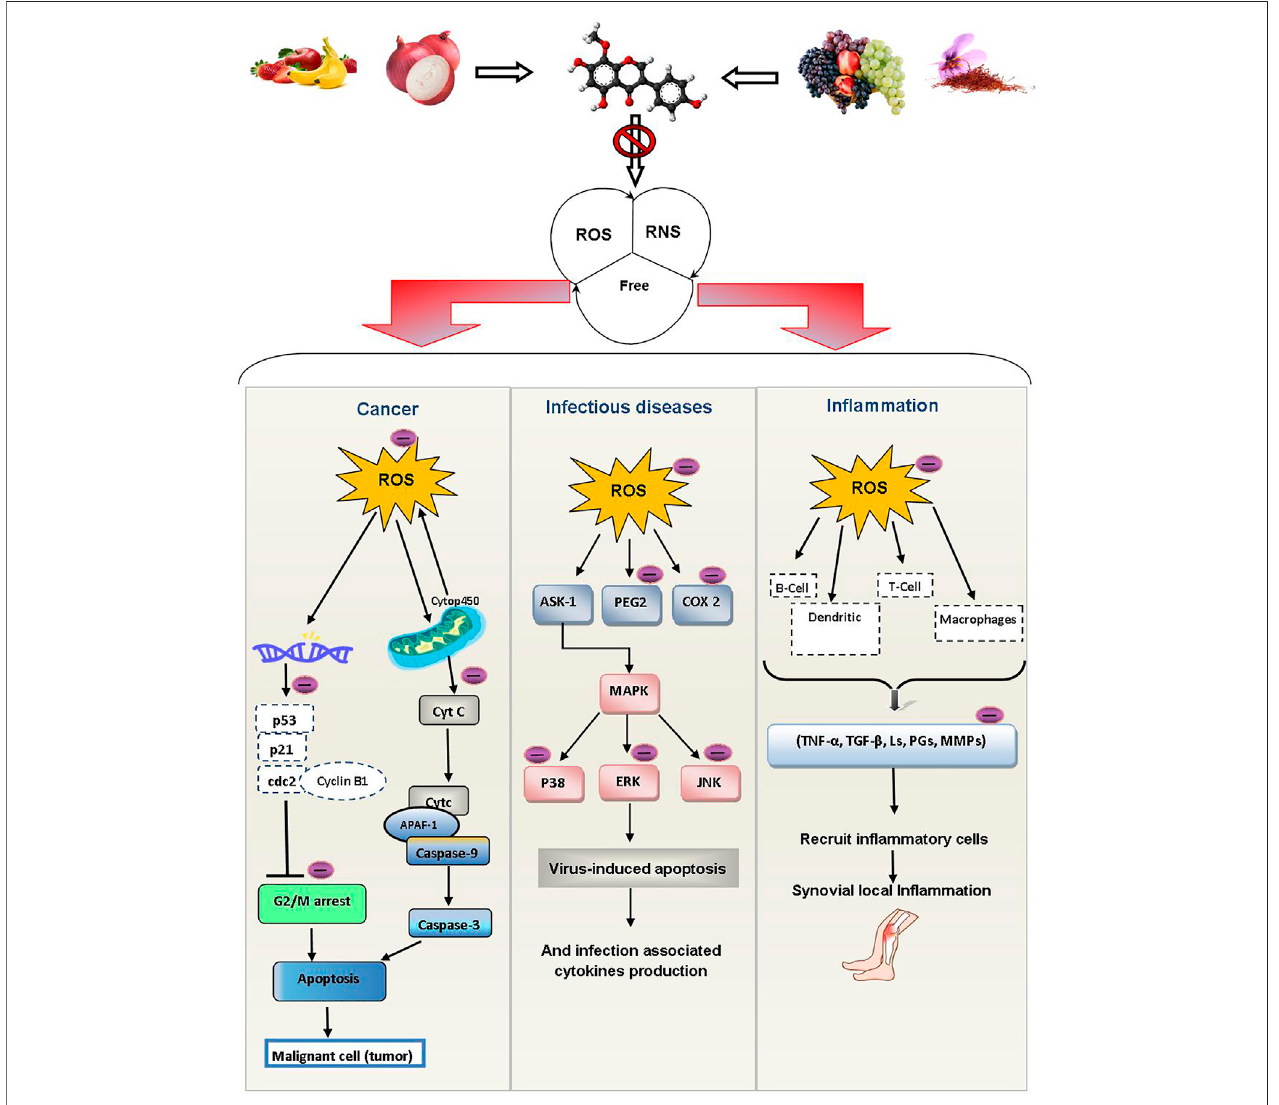
FIGURE 8 | Protective effects of dietary polyphenols against cancer, infectious illness and in fl ammatory diseases. Abbreviations: ROS: reactive oxygen species, RNS: reactive nitrogen species, P53: tumor protein 53, P21: tumor protein 21, CDC2: cell division control 2, CASPASE-9: cysteine-dependent aspartate-directed protease-9,APAF-1:apoptoticproteaseactivatingfactor-1,Cytc:cytochromec,Cytp450:cytochromeP450,G2/Marrest:cellcycle “ gap2 ” mitoticphasearrest,ASK- 1:apoptosissignal-regulatingkinase-1,PEG2:polyethyleneglycol2,COX2:cyclooxygenase2,MAPK:mitogen-activatedproteinkinase,P38:mitogen-activated proteinkinaseprotein38,ERK:extracellularsignal-regulatedkinase,JNK:JunN-terminalkinase,B-cells:Blymphocytescells,TNF-alpha:Tumornecrosisfactor-alpha, TGF- β : transforming growth factor beta, Ls: lipid hydro-peroxides, MMPs: matrix metalloproteinases, PGs: prostaglandins.